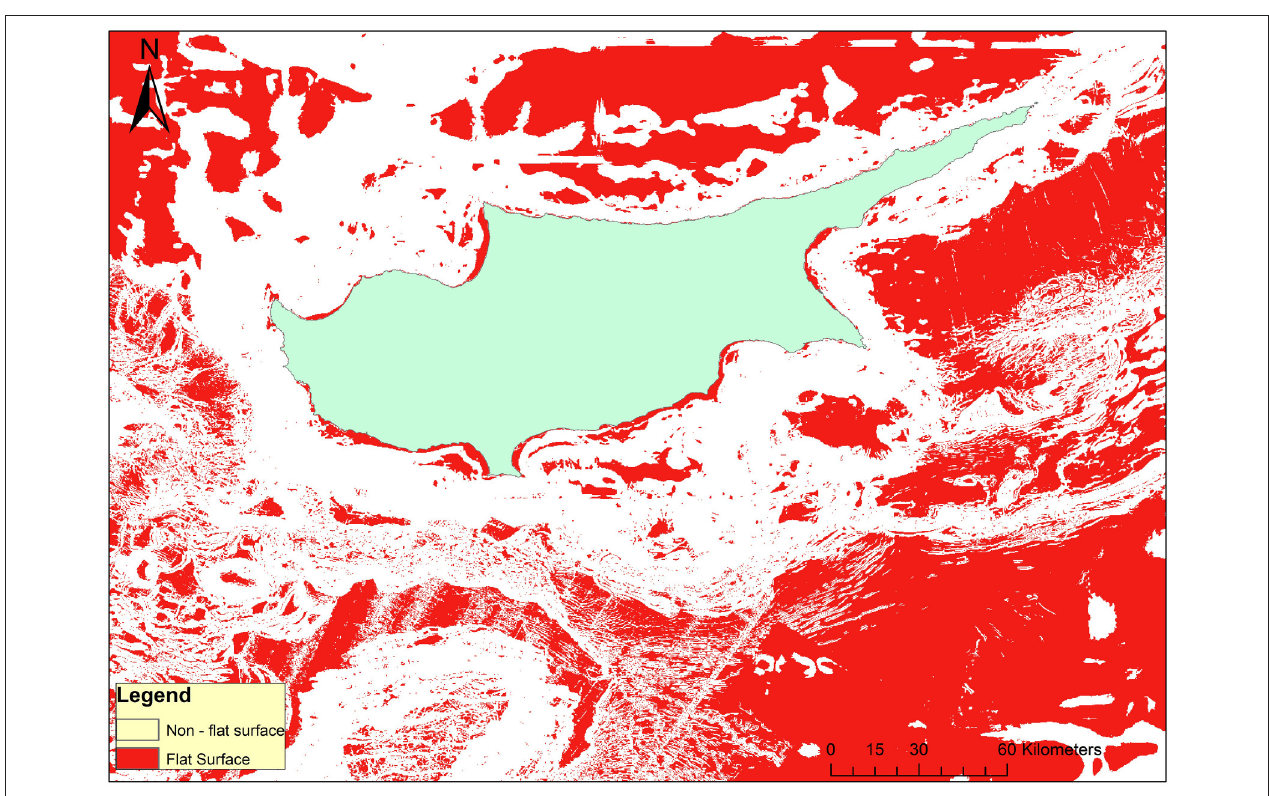
FIGURE 10 | Flat seafloor areas (in red) around